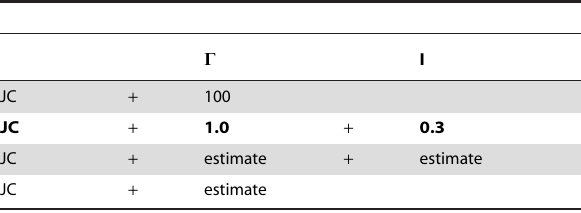
Table 1. The used model parameter settings of ASRV for maximum likelihood